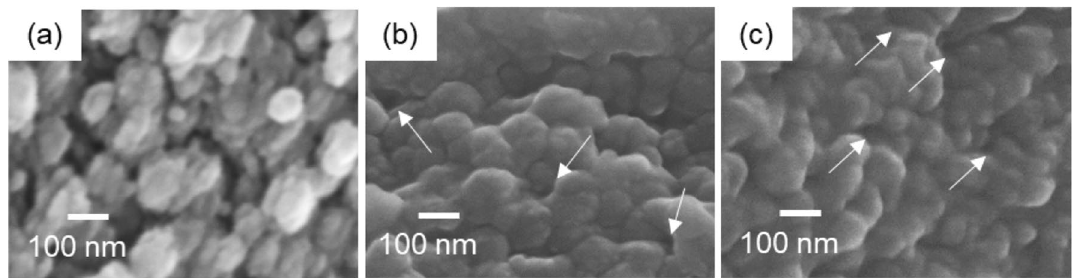
Figure 5. SEM images of silica particles in the surface plate of a mature leaf blade after calcination ( a ) and treatments with cellulase ( b ) and the ionic liquid ( c ). White arrows indicate holes that were formed after dissolution of the